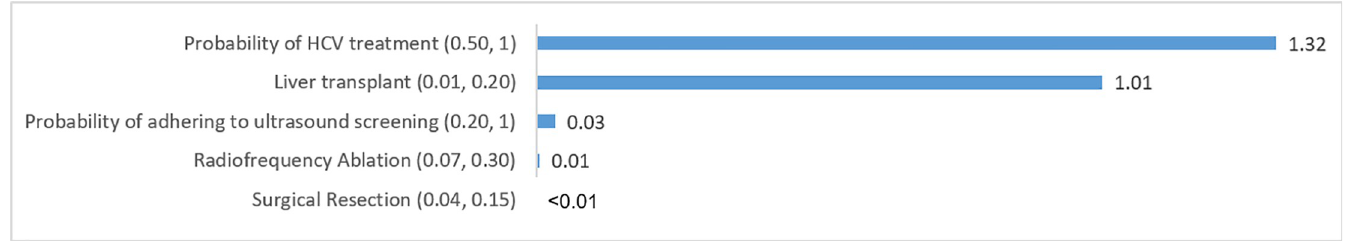
Fig 5. Life expectancy gains when key variables are raised to their aspirational value, one-way sensitivity analysis results. Graph shows gains in life expectancy (years) when variables were increased from their base case value to their aspirational value. Base case and aspirational values are in parentheses.